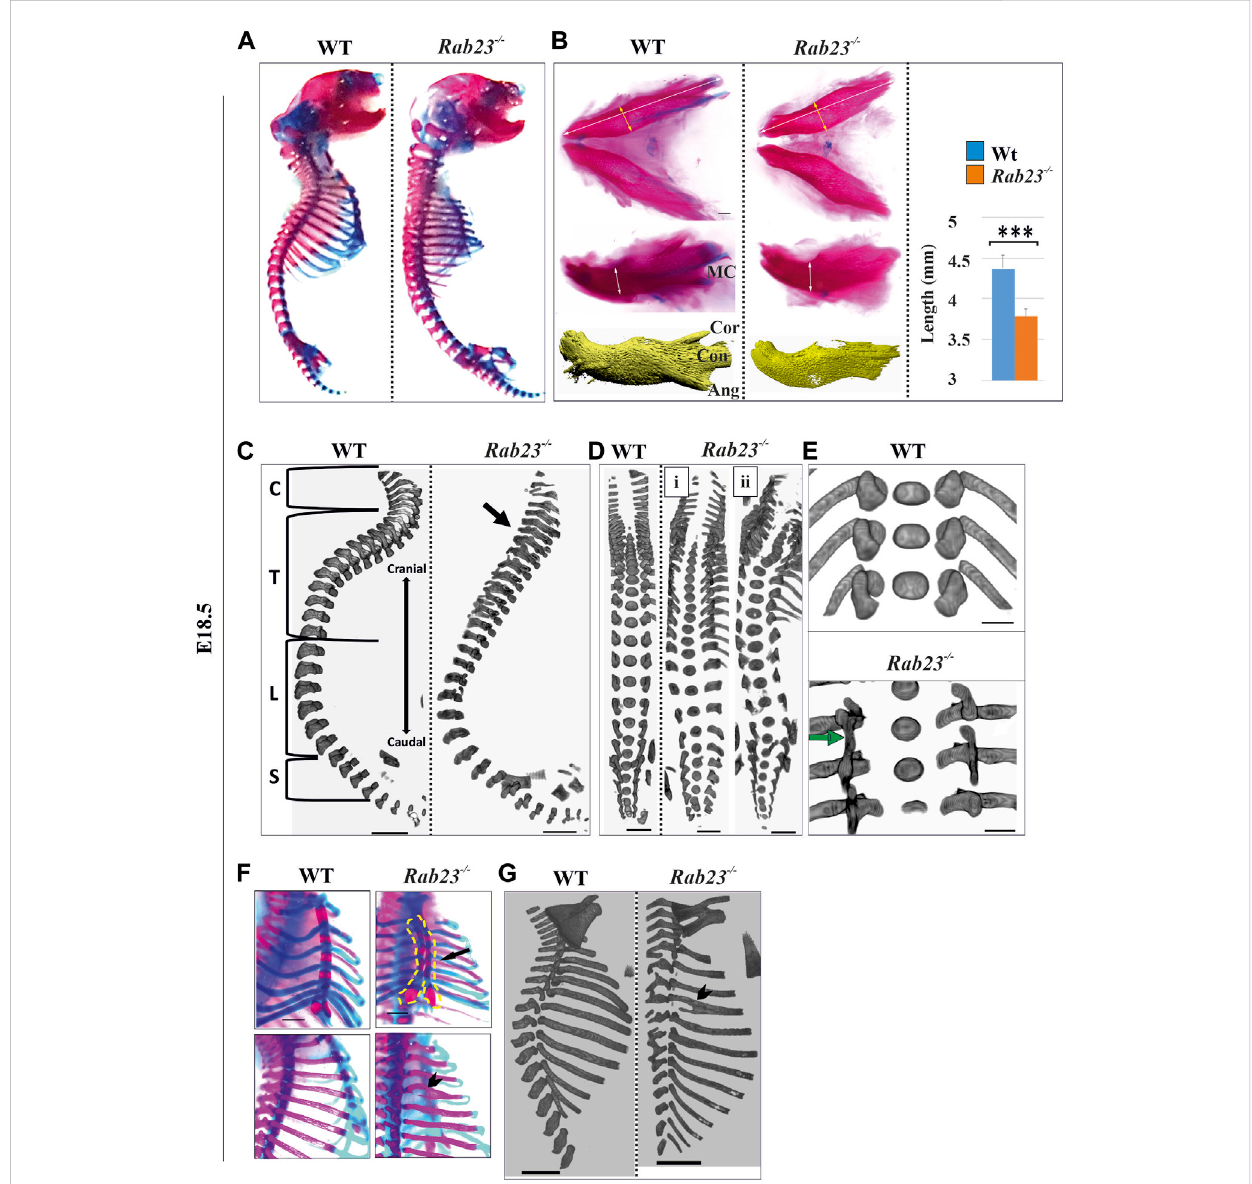
FIGURE 7 Rab23 − / − mice show diverse skeletal phenotypes. (A) Alizarin red (bone) and Alcian blue (cartilage) staining of whole WT and Rab23 − / − mice at E18.5 showing the craniofacial, axial, and appendicular skeleton except for the fore and hind limbs ( n = 5 for each age and genotype). (B) Alizarin red, Alcianbluestaining,andµ-CTimagesofthemandibleofWtand Rab23 − / − miceatE18.5.Themandibularprocesses;cor:coronoidprocess,con:condylar process,andang:angularprocessesarepoorlydevelopedin Rab23 − / − mice. Rab23 − / − mandiblesaresmallerthanWtsamples( n =6foreachageand genotype). Statistical signi fi cance was de fi ned as p value ˂ 0.001 (***). (C – E) μ -CT images of the vertebral column of Wt and Rab23 − / − mice at E18.5. Rab23 − / − mice show neck fl exure defect (C. arrow), scoliosis (D), and fused vertebrae thoracic T6-T8 (E, arrow). Scale bar: 1 mm (C, D). (F, G) Alizarin red, Alcian blue staining, and µ-CT images of ribs of Wt and Rab23 − / − mice at E18.5. Rab23 − / − mice show split sternum (F, arrow) and bi fi d ribs (F and G, arrowhead) ( n = 5 for each age and genotype). Scale bar: 1.5 mm (E) , 1 mm (F) , and 2 mm (G)